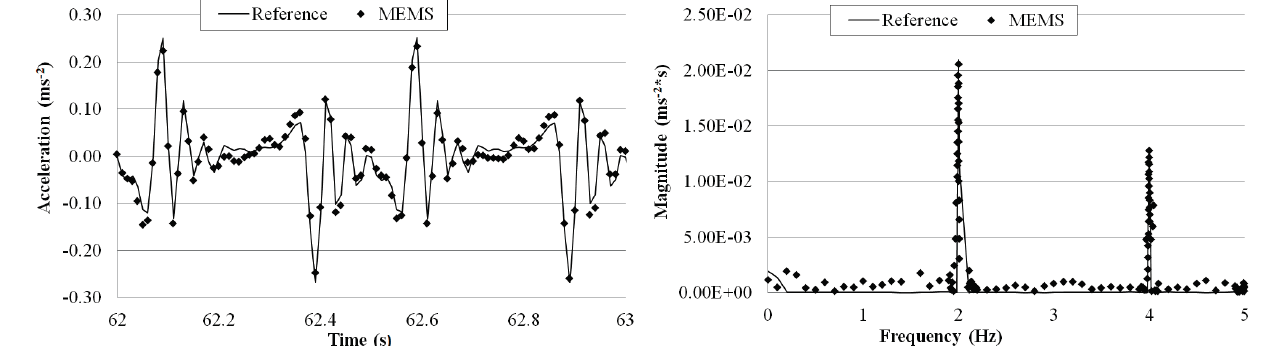
Figure 22. Comparison of measurements by the two sensors in time and frequency domains (2 Hz Periodic Wave Excitation).